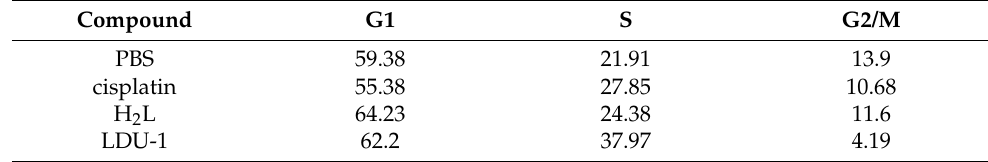
Table 4. Proportion of tumor cells in cell cycle